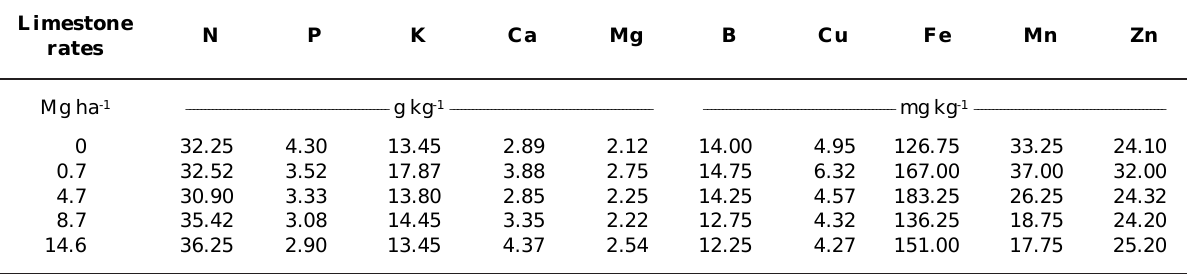
Table 2. Macro and micronutrients in the leaves of peach palm plants two years after planting. Pariquera- Açu, São Paulo, Brazil Limestone N P K Ca rates Mg ha